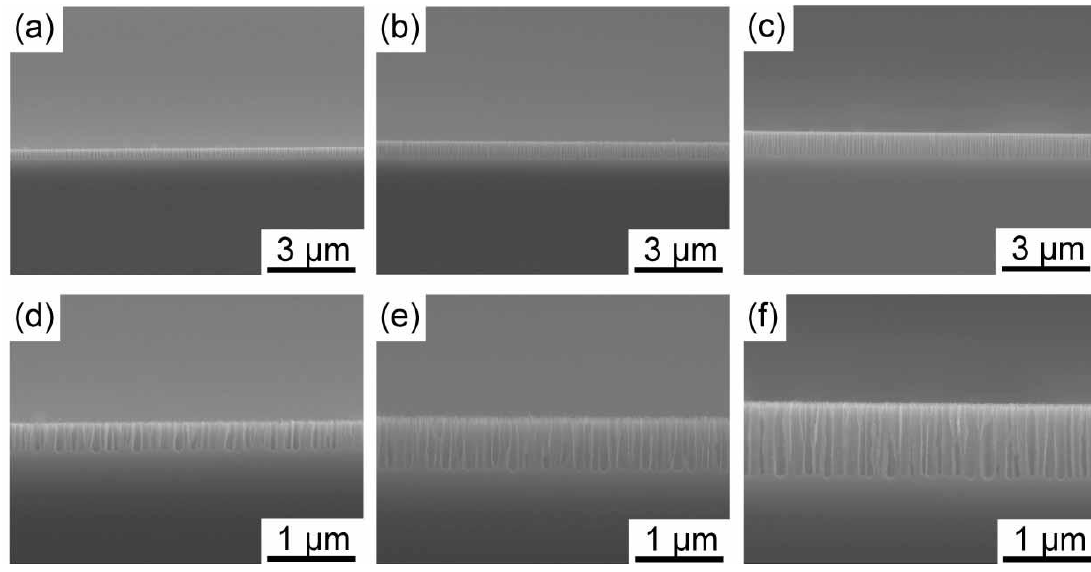
Figure 1. SEM images of medium-sized pores formed in n + -Si(100) at a current density of 44.6 mAcm  2 with different anodization times. The upper and lower rows show low and high magnification images. The anodization time was 14, 28, and 42 s for ( a , d ), ( b , e ) and ( c , f ),